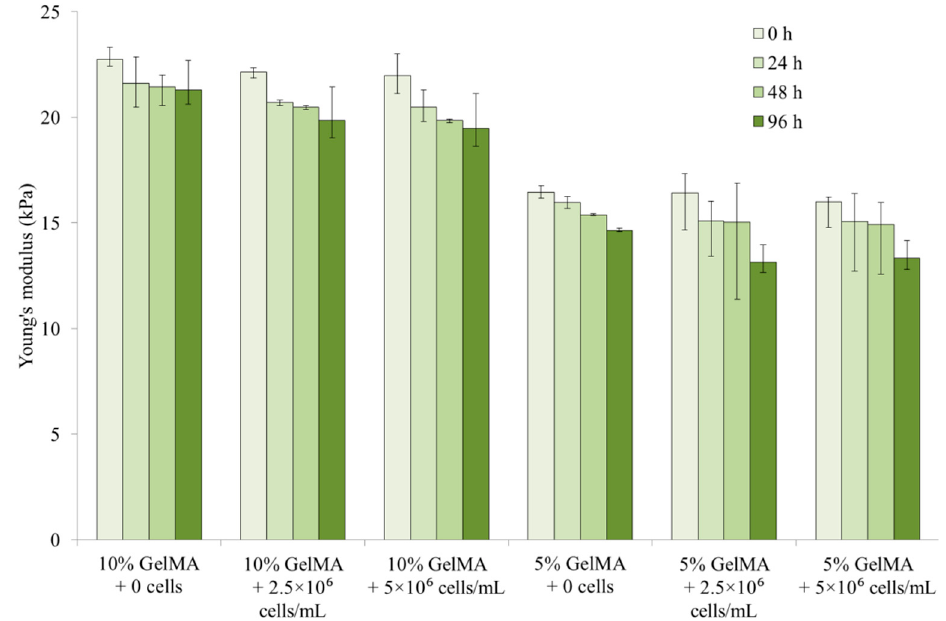
Figure 5. Tensile moduli of GelMA hydrogels with different GelMA concentrations and cell densities at different incubation times. The error bars indicate the minimum and maximum values of the calculated tensile moduli